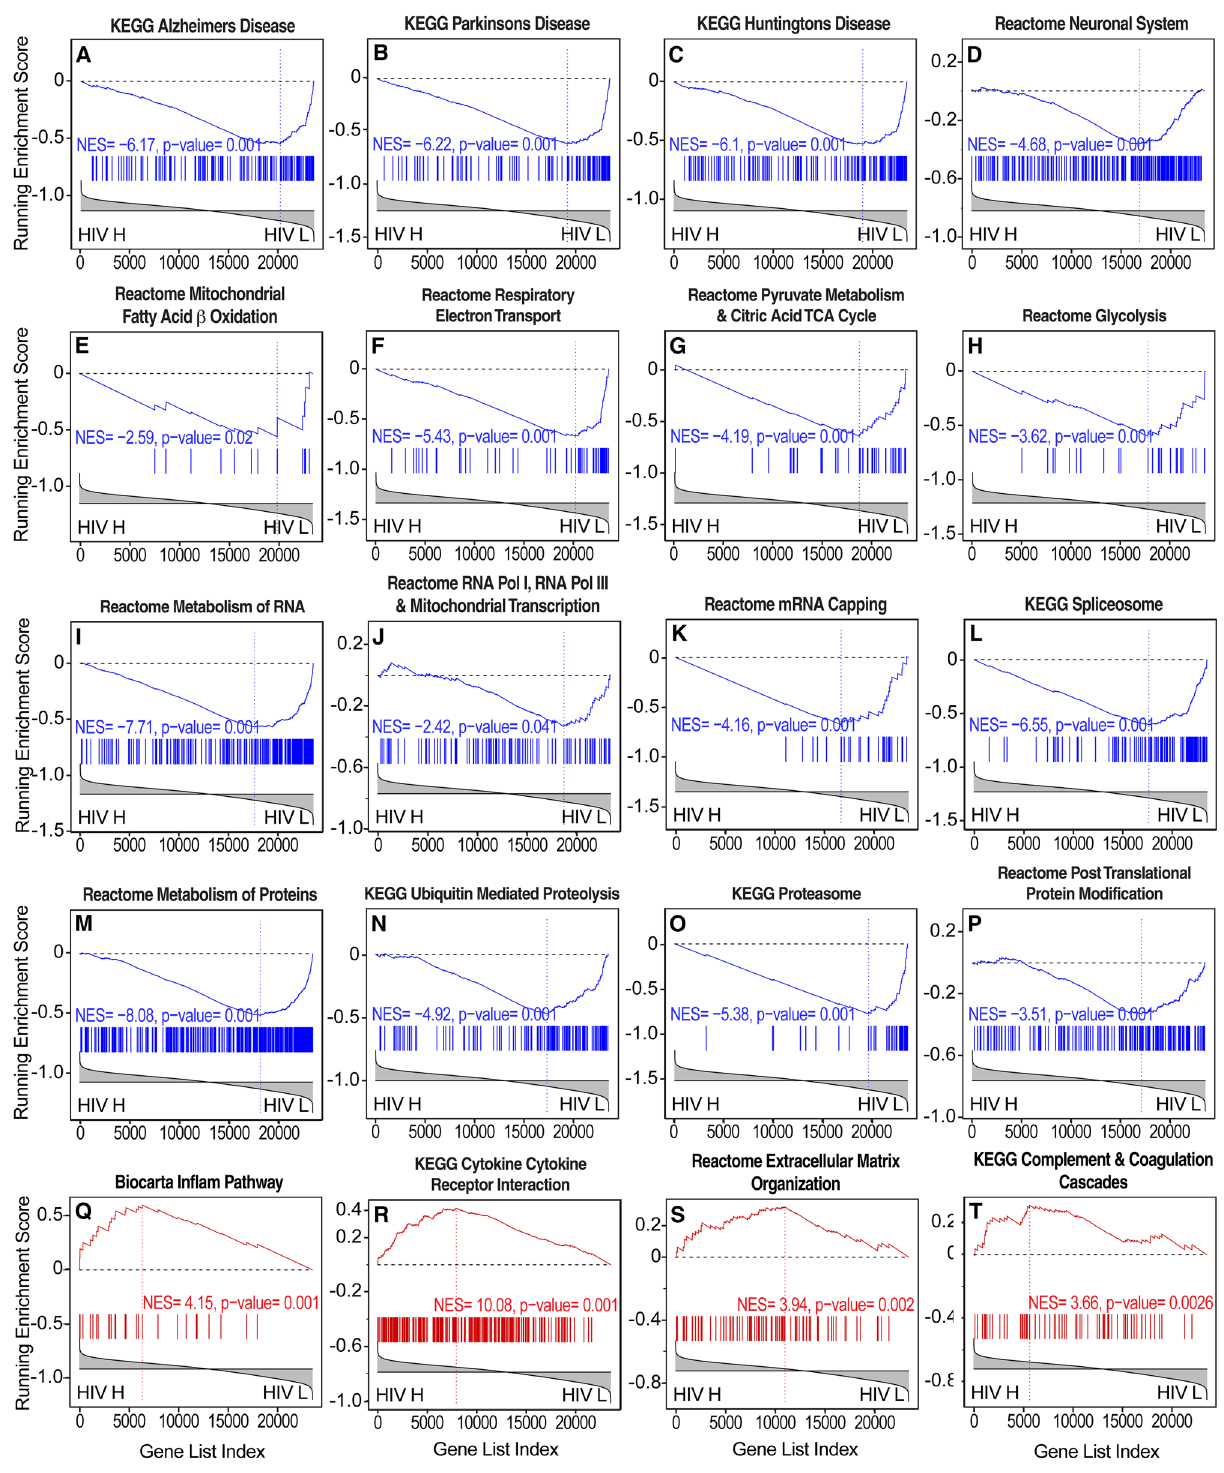
Figure 8. Representative pathways indicative of neurodegeneration, impairments in bioenergetics, and neuroinflammation correlated with brain HIV RNA load in the frontal cortex. ( A – C ) The pathway analysis by GSEA demonstrated transcriptional changes that are indicative of neurodegeneration, including pathways representative of gene expression changes in AD, PD, and HD. ( D ) Gene expression changes indicated a reduction of neuronal signaling that is consistent with synaptodendritic injury, ( E – H ) impairments in mitochondrial function and energy metabolism, including reductions of TCA cycle, electron transport, and glycolytic genes, ( I – L ) impairments in RNA synthesis and processing, ( M – P ) proteostasis and protein synthesis, ( Q , R ) increased inflammation and cytokine signaling, ( S ) extracellular matrix, and ( T ) complement genes. HIV H, high brain HIV RNA load; HIV L, low brain HIV RNA